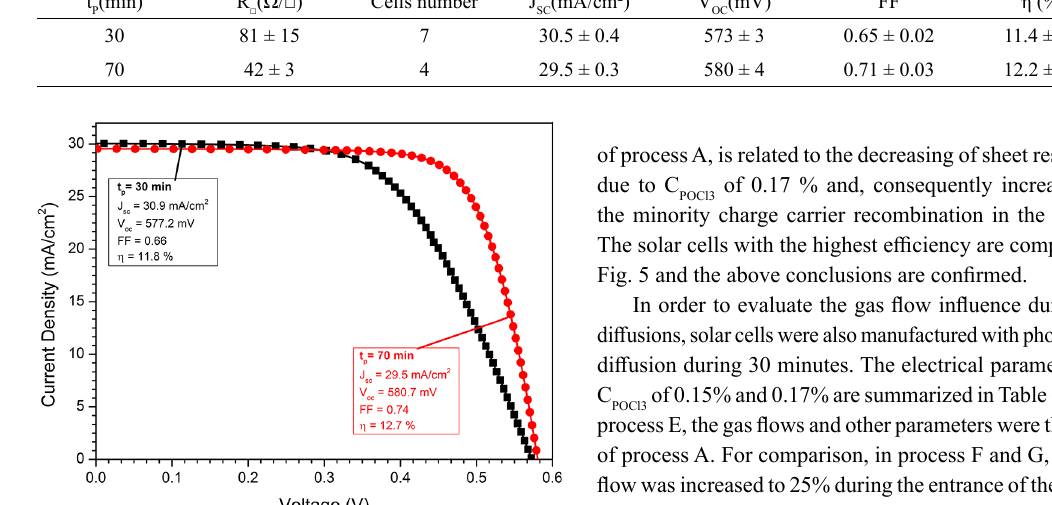
in the quartz 3